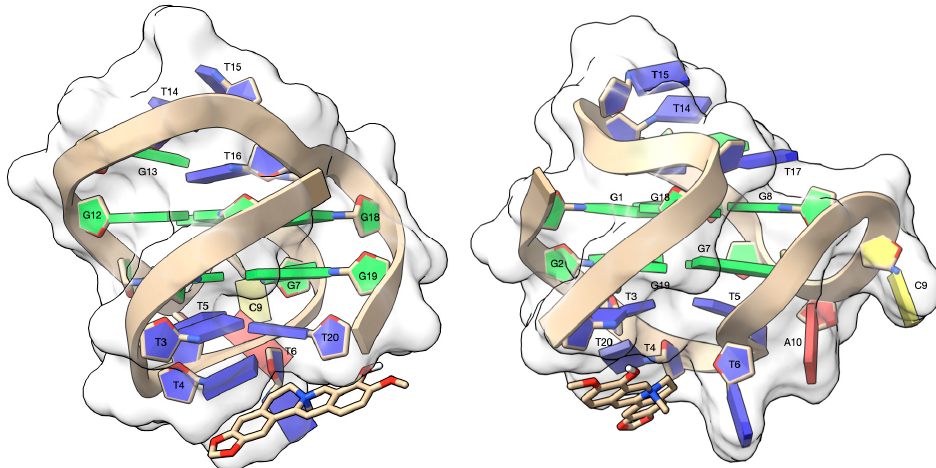
Figure 7. Side views of the complex between escholidine and the DL40 G-quadruplex, as obtained from the molecular docking experiment. The G-quadruplex target is contoured by a ghostly-white solvent accessible surface (SAS) and the nucleotides were depicted as filled rings: adenine in red, cytosine in yellow, guanine in green and thymine in blue. The escholidine alkaloid is represented as van der Waals (vdW) spheres and coloured according to the atom types. The drawing was created by using the Chimera-X software (Resource for Biocomputing, Visualization, and Informatics San Francisco, CA, USA) [63].